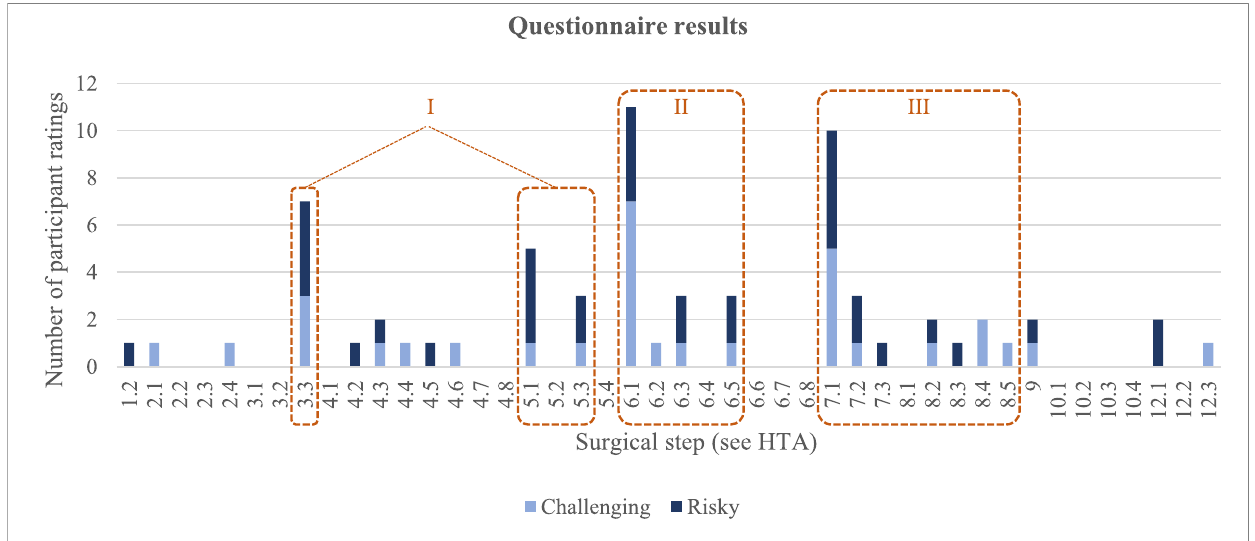
Fig 2. Assessment of surgical steps in terms of risk and challenge. Numbers greater than nine are due to participants rating steps as challenging and risky.